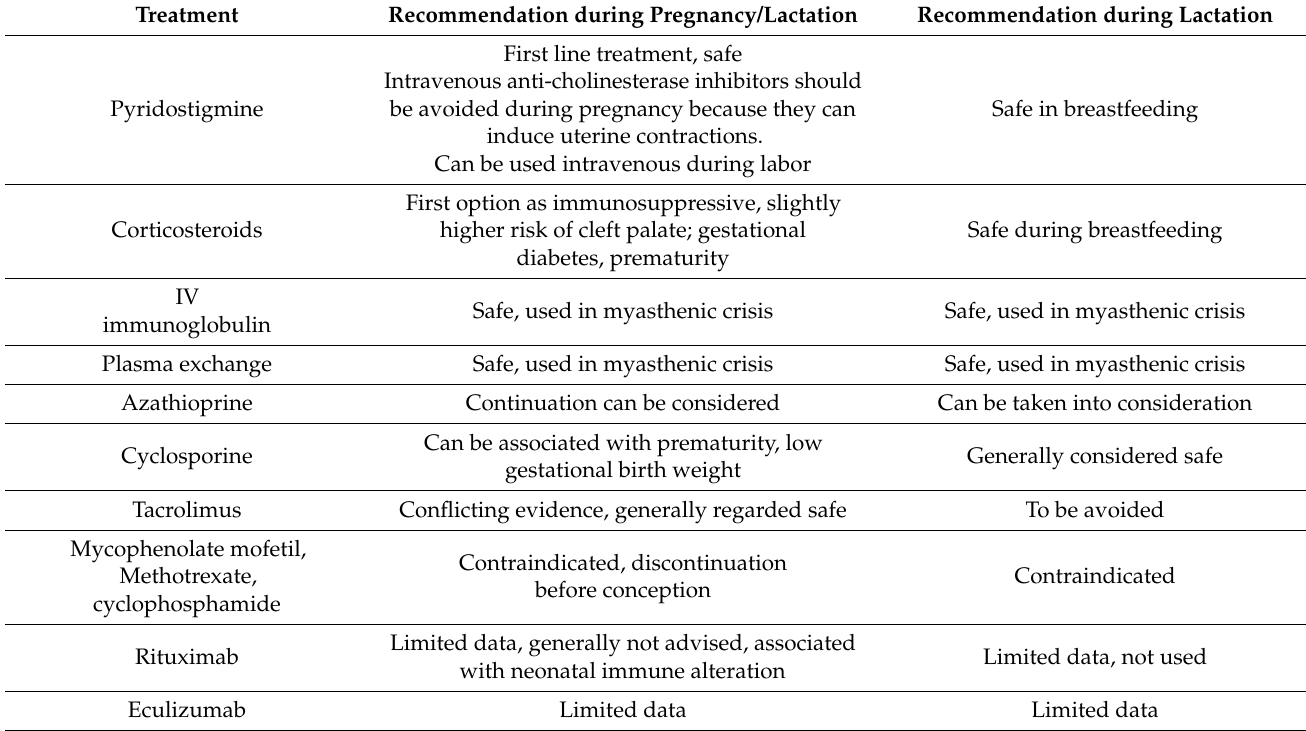
Table 2. Treatment recommendations during pregnancy and